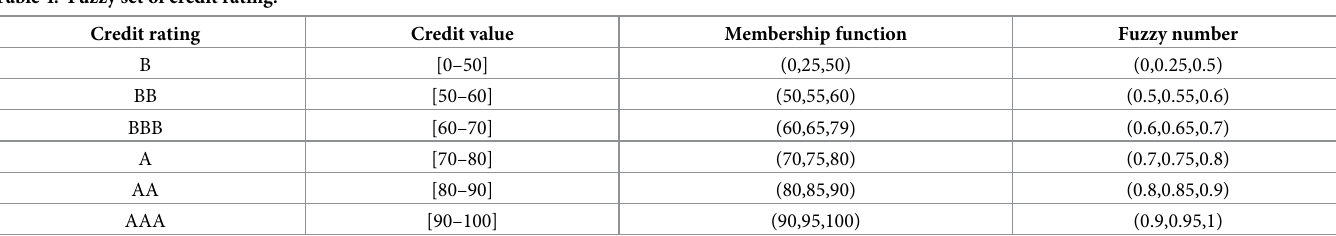
Table 4. Fuzzy set of credit